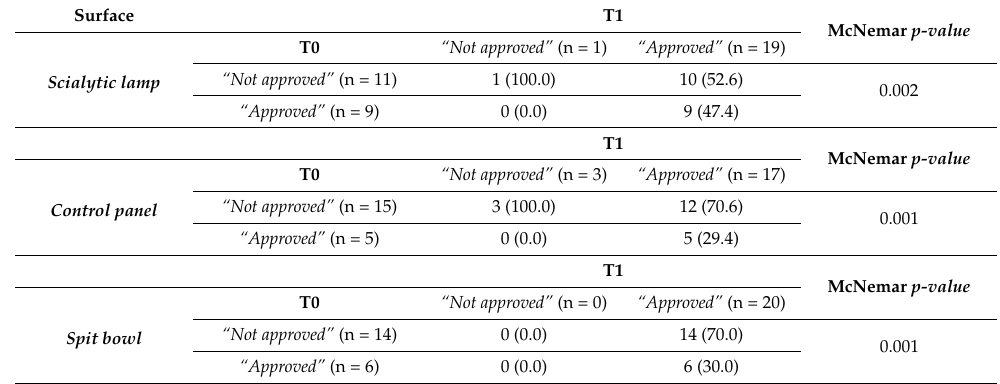
Table 4. Paired distribution between categorical disinfection data at T0 and T1 for each evaluated surface; ( p <